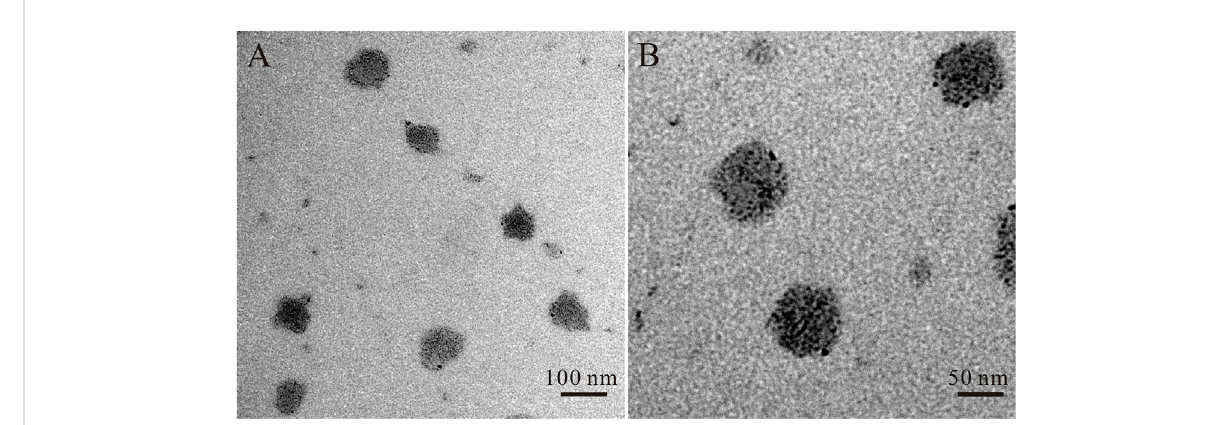
FIGURE 1 The TEM images of OEA Liposomes.